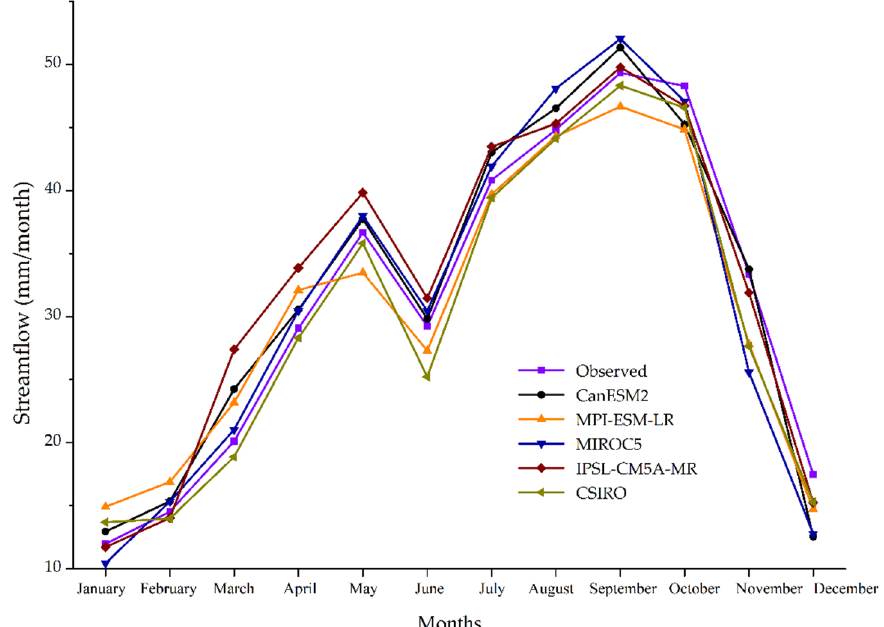
Figure 8. Observed and GCM simulated monthly streamflows in the baseline (1986–2005)